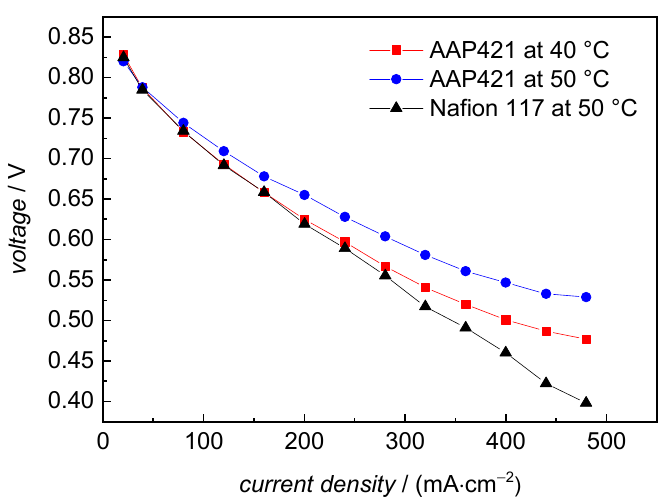
Figure 7. Polarization curves measured for AAP421 in a fuel cell at 40 and 50 °C. Data for Nafion 117 are taken from [44].